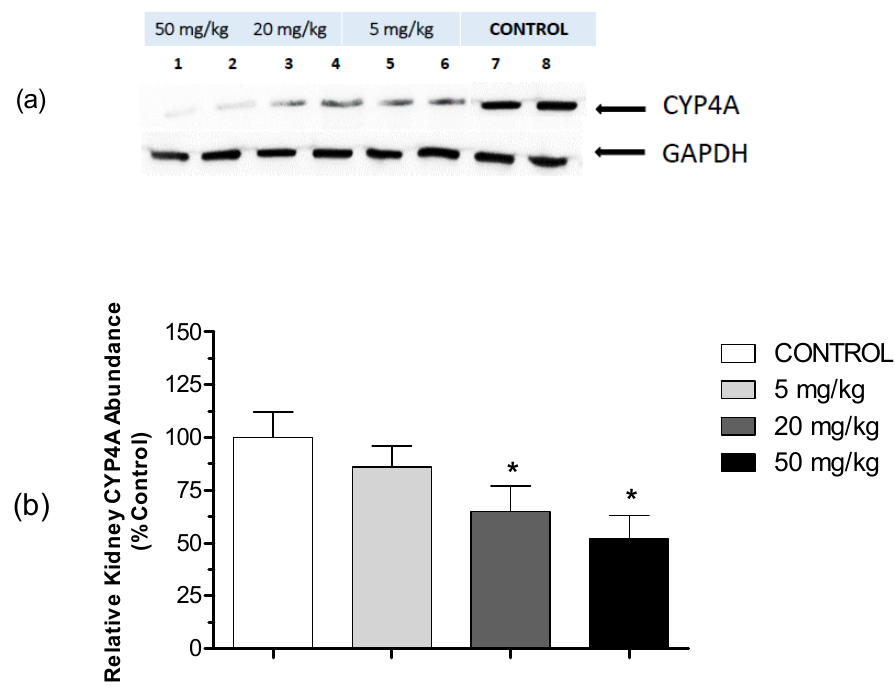
Figure 5. Effect of HON on kidney expression of CYP4A. The immunoreactive proteins were detected via enhanced chemiluminescence and x-ray film imaging, and the resultant signals were an- alyzed by densitometry. The intensity of the band was normalized to a loading control (GAPDH signal), then data were expressed as percentages of the control values. ( a ) The original specimen analyzed by densitometry (control, lanes 7–8; low-dose HON, lanes 5–6; medium-dose HON, lanes 3–4; and high-dose HON, lanes 1–2). ( b ) Renal CYP4A protein levels in rats ( n = 8/group) treated intraperitoneally daily for 3 weeks with HON at different doses. Results are expressed as the per- centages of control levels in untreated rats. All groups were compared using one-way ANOVA fol- lowed by multiple comparisons. * Significant difference from control with p < 0.05. 2.4. Effect of HON Treatment on Soluble Epoxide Hydrolase (sEH) Activity To investigate the potential inhibitory effect of HON on the activity of sEH, an en- zyme that hydrolyzes the cardioprotective effect of eicosanoids to inactive diols, we meas- ured the activity of this enzyme in kidney cytosolic fractions from control and HON- treated SHR. The results shown in Figure 6 indicate that the sEH activity was inhibited by 30% and 44% ( p < 0.05) following administration of medium (20 mg/kg) and high (50 mg/kg) doses of HON, respectively. Administration of the low dose (5 mg/kg), on the other hand, did not result in significant inhibition of sEH activity. K i dn ey s E H A c t i v i t y ( % C on t r o l )